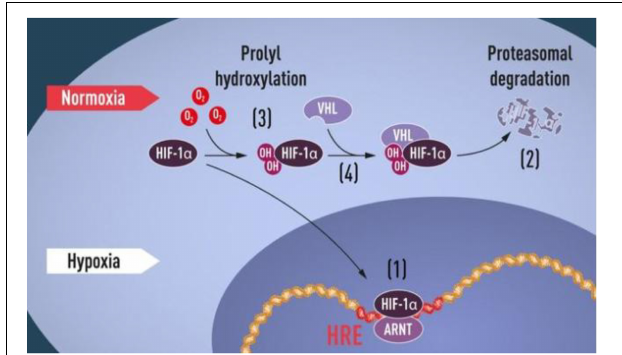
FIGURE 1 | “HIF-1 α Pathway”, Press release: The Nobel Prize in Physiology or Medicine 2019. NobelPrize.org. Nobel Prize Outreach AB 2022. Sat. 22 Jan 2022